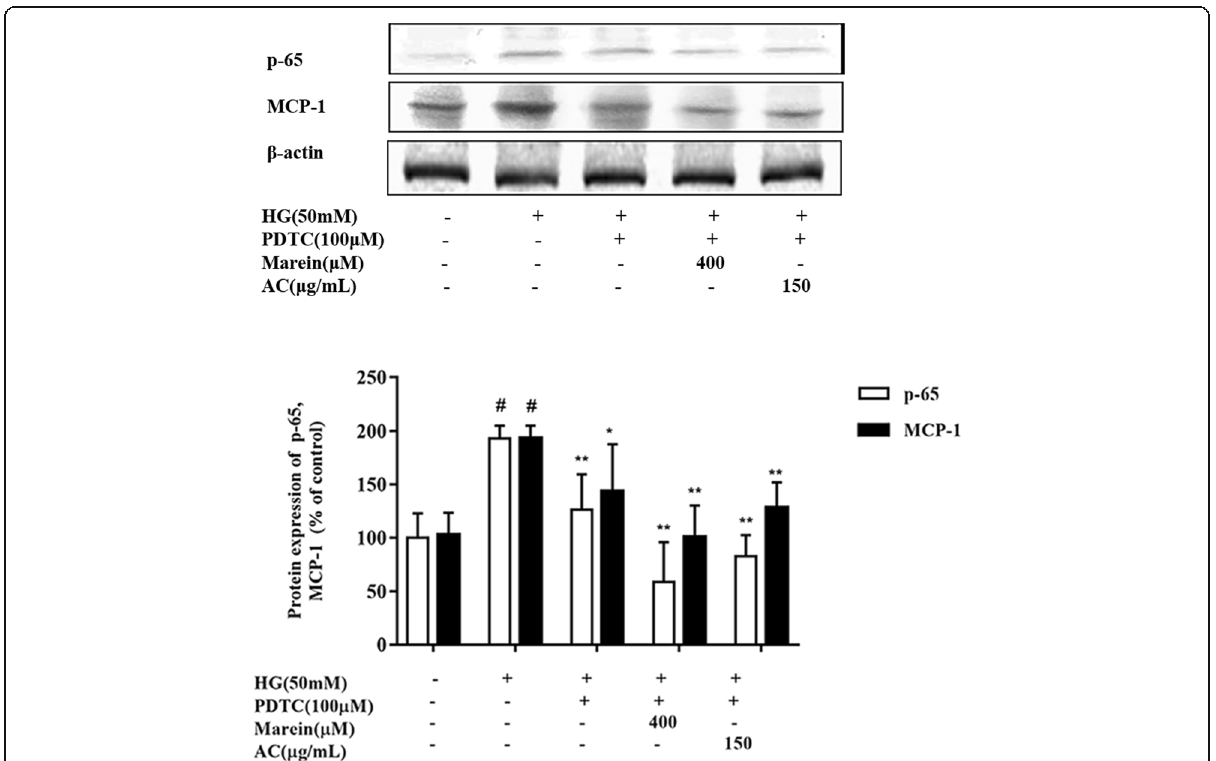
Fig. 7 Effect of AC and marein on NF- κ B signaling. HBZY-1 cells were pretreated with AC and marein for 2 h, and then stimulated with PDTC, an NF- κ B inhibitor followed by NG or HG exposure for 24 h. Equal amounts of lysate were subjected to western blotting analysis to determine NF- κ B P-65 and MCP-1. Note: Values were expressed as the mean ± SD, n = 4. # P < 0.01 versus normal group; * P < 0.05 versus control group; ** P < 0.01 versus control